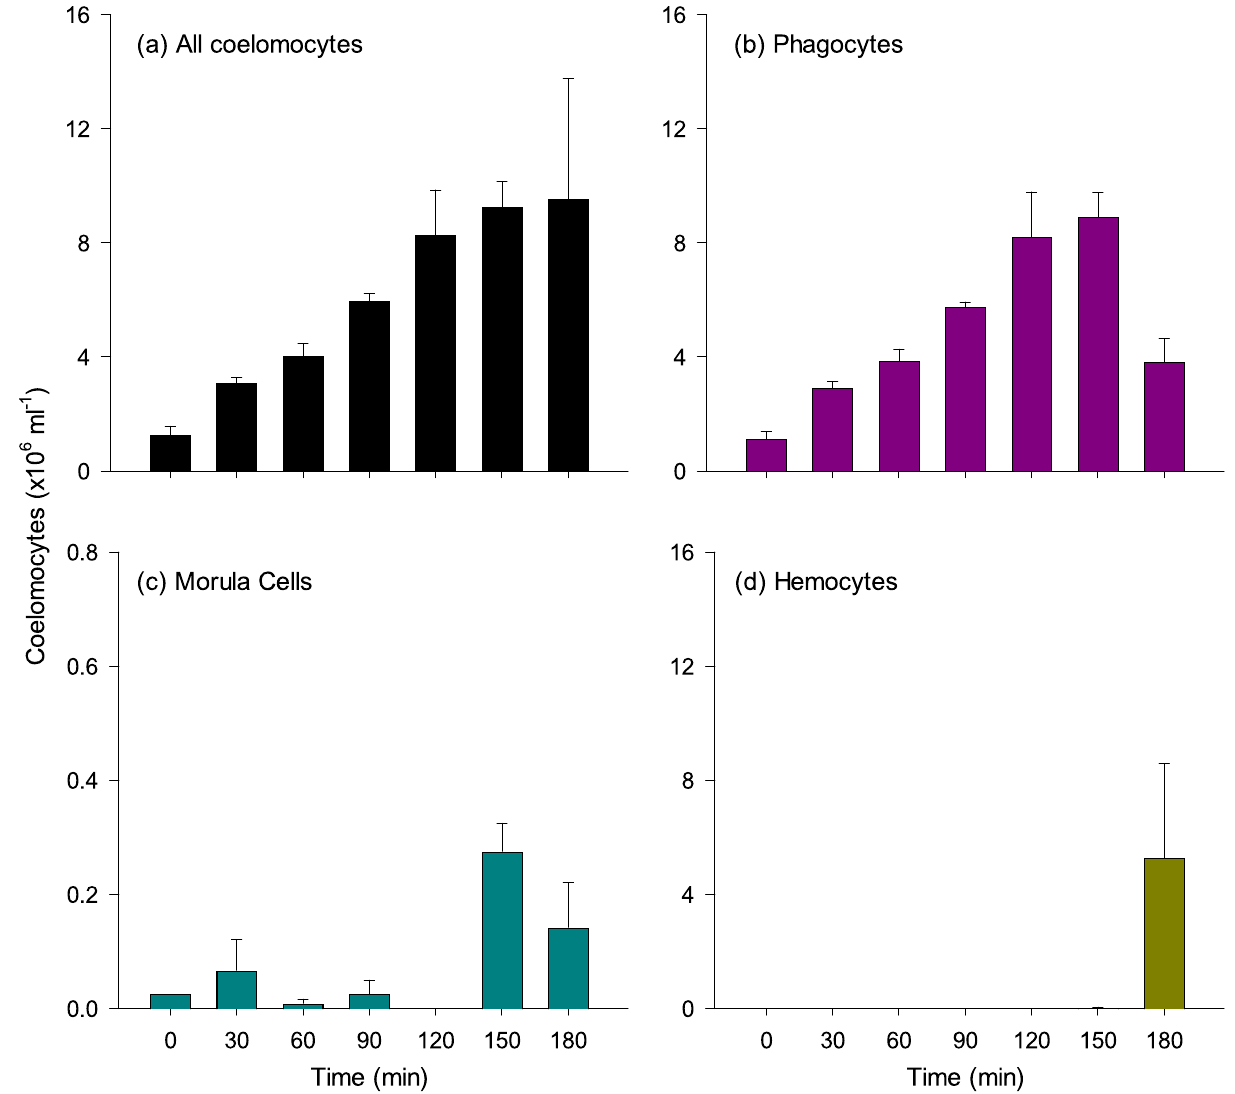
Figure 2. Immune response of Cucumaria frondosa to contactless exposure to the chemical signature of a predator over 180 min (3 h). Coelomocyte density was measured in the hydrovascular fluid of the Polian